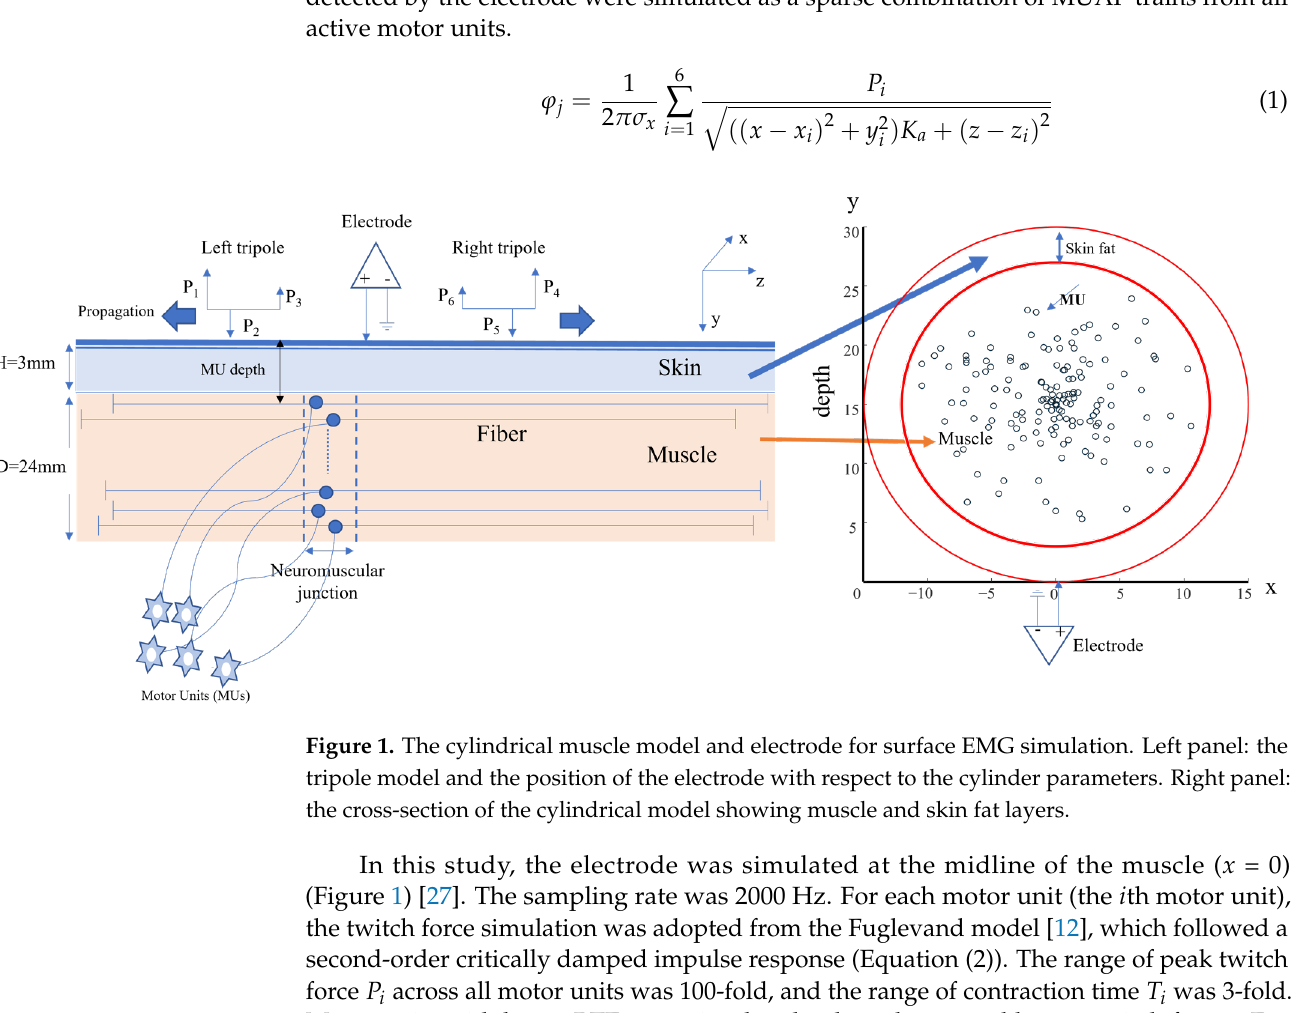
Figure 2. Three different motor unit distributions with respect to muscle depth. ( A ) motor unit depth is negatively related with motor unit size. ( B ) motor unit depth is randomly assigned. ( C ) motor unit depth is positively related to motor unit size. 2.2. Experimental Study 2.2.1. Participants and Consent Nine subjects (8 male, 1 female, 28.9 ± 4.8 years, mean ± SD) participated in the ex- periment. They were recruited by word of mouth or posters and had no known history or symptoms of any neuromuscular disorder. All subjects were well informed of the